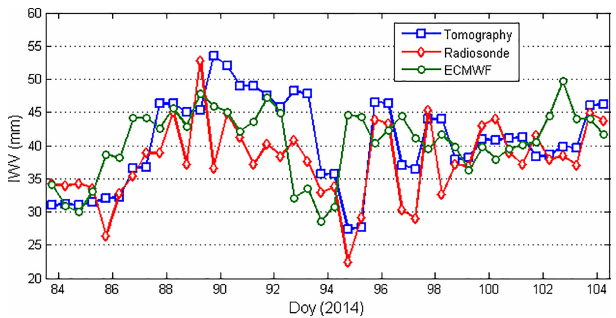
Table 4. Statistical results of water vapor density between